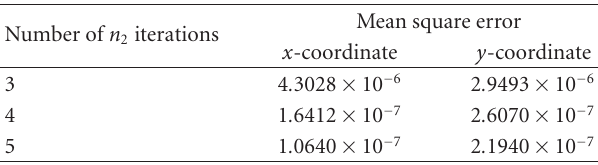
Table 2: Mean square error in x -coordinate and y -coordinate for varying n 2